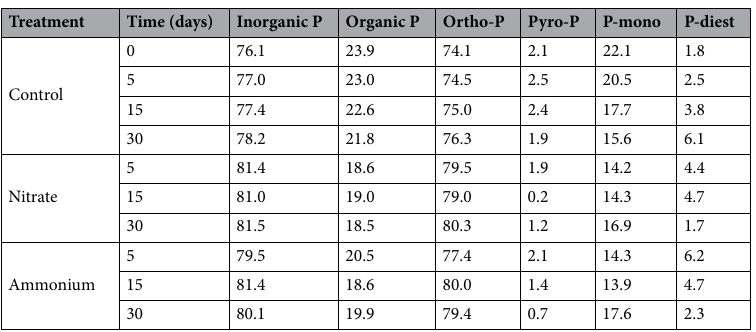
Table 2. Percent of inorganic P, organic P, inorganic orthophosphate, inorganic pyrophosphate, orthophosphate monoesters, and orthophosphate diesters, as determined by 31 P NMR.